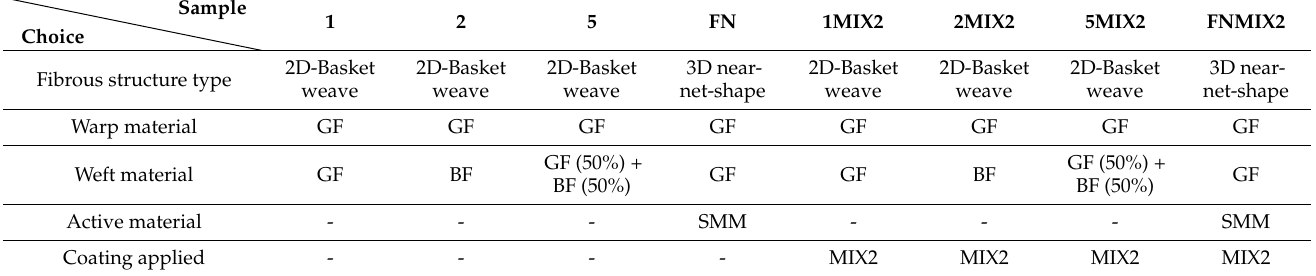
Table 2. Final samples designation for fire curtains varying in structure, materials combination, and